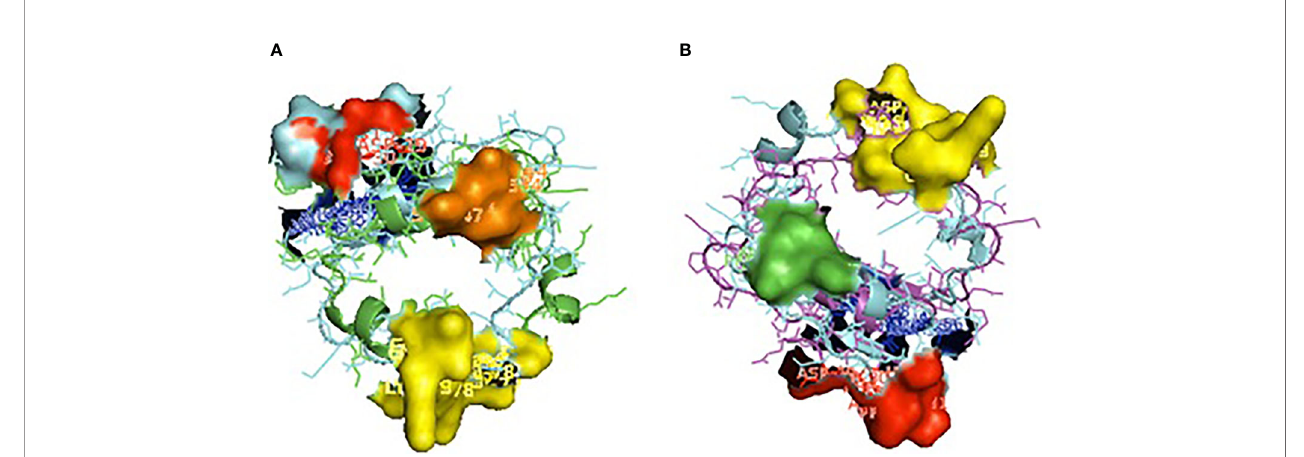
FIGURE 5 | Depiction of receptor binding site for CD14. (A) Pocket or groove (LPS binding site) for TM aligned CD14 sheep and CD14 buffalo. (B) Pocket or groove (LPS binding site) for TM aligned CD14 sheep and CD14